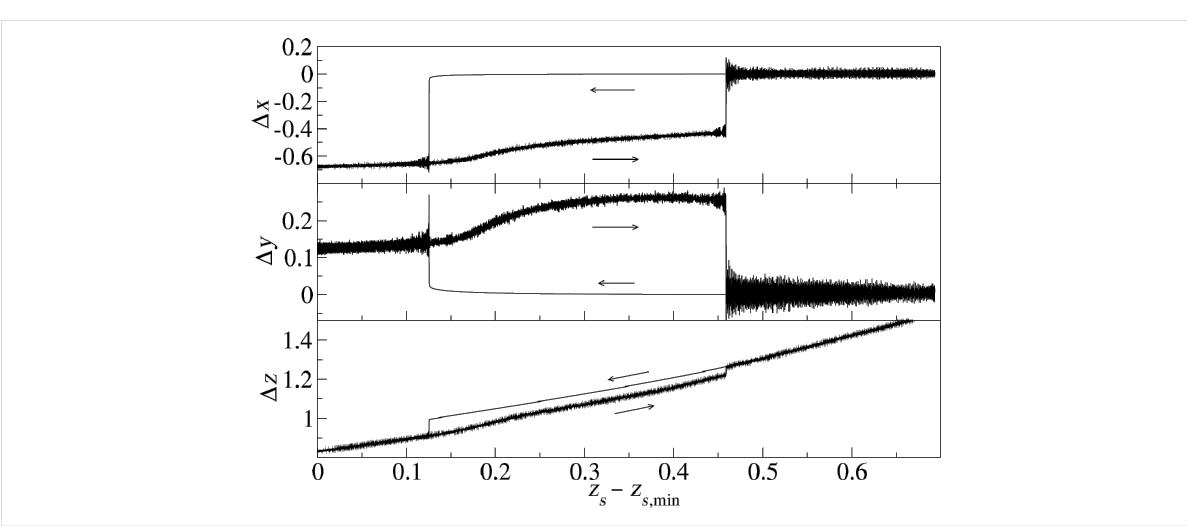
Figure 5: Trajectory of the apex atom at tip position A (Figure 2). Δ x and Δ y are its x - and y -coordinates relative to their values at time t = 0. The z -co- ordinate Δ z is given relative to z surf .